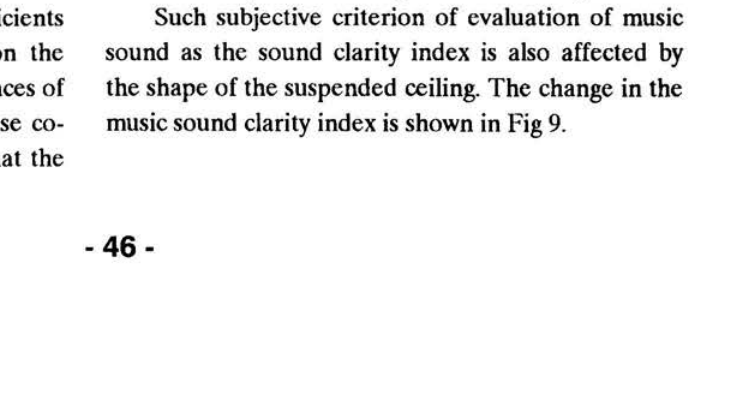
Fig 7. The increase in the relative sound absorption coeffi cients of the hall depending on the form of the slits in the suspended ceiling and the overall slit area. 1 - cross-shaped slits; 2 - rectangularly-shaped slits Negative values correspond to the increase in the